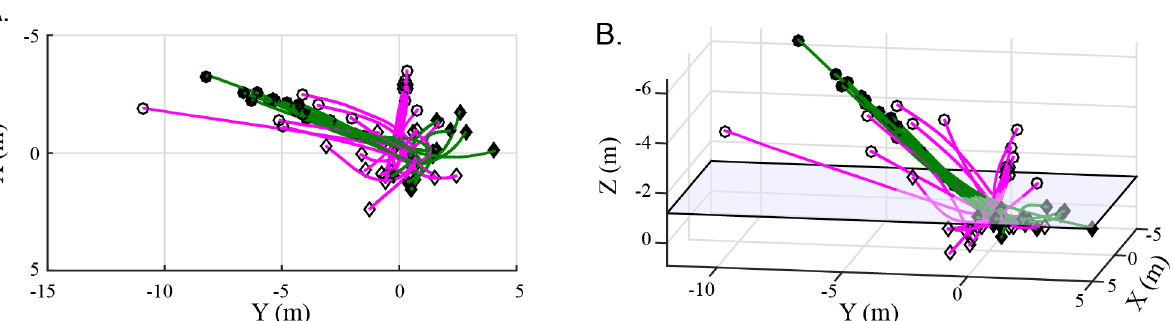
Fig 2. Defending bird trajectories and their classification. Circles indicate the starting position of the bird trajectory and diamonds its end position. Green lines with solid markers represent defenders using the perch, which was not within the 3D reconstruction volume. The pink lines with open markers represent other defender trajectories. A) A top-down view of the flight trajectories of the defending birds. B) A 3D view of the defending birds. The transparent blue plane at Z = 1.2m represents the approximate end of the uniform descent period of defender